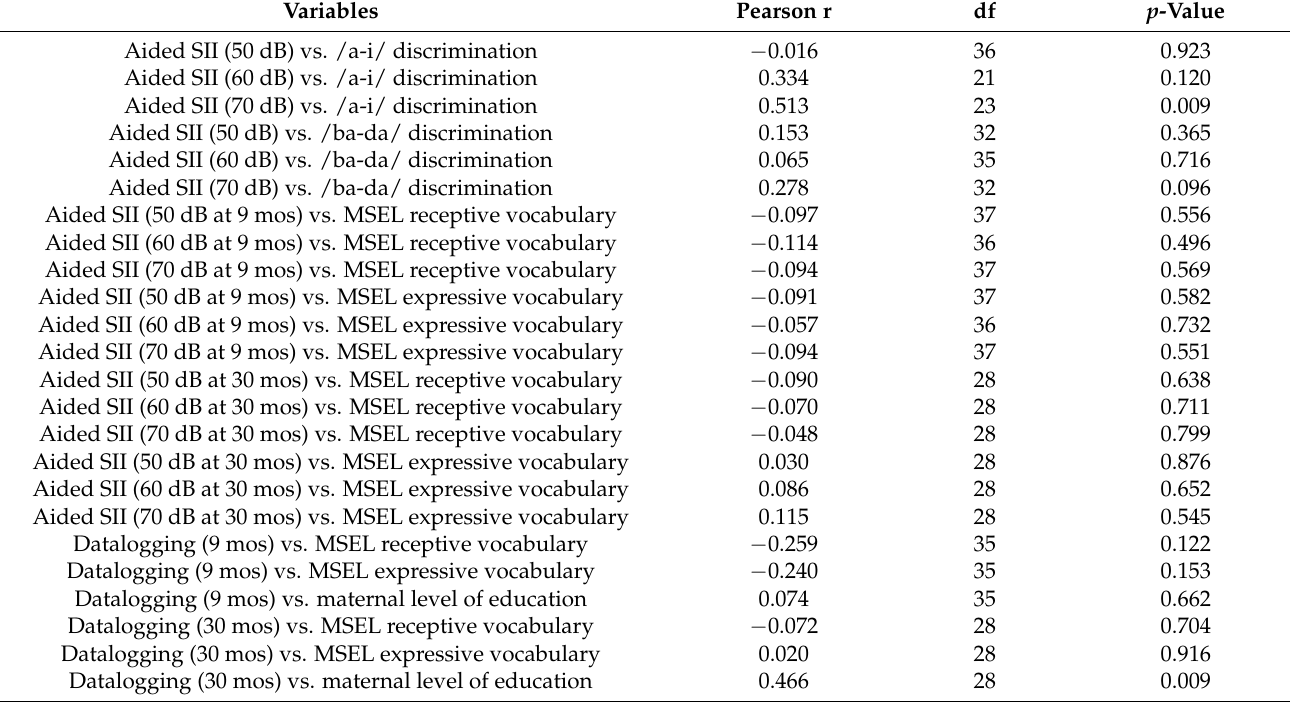
Table 10. Correlations between aided Speech Intelligibility Index (SII), speech contrast, datalogging measures, and Mullen Scales of Early Learning (MSEL) receptive and expressive vocabulary